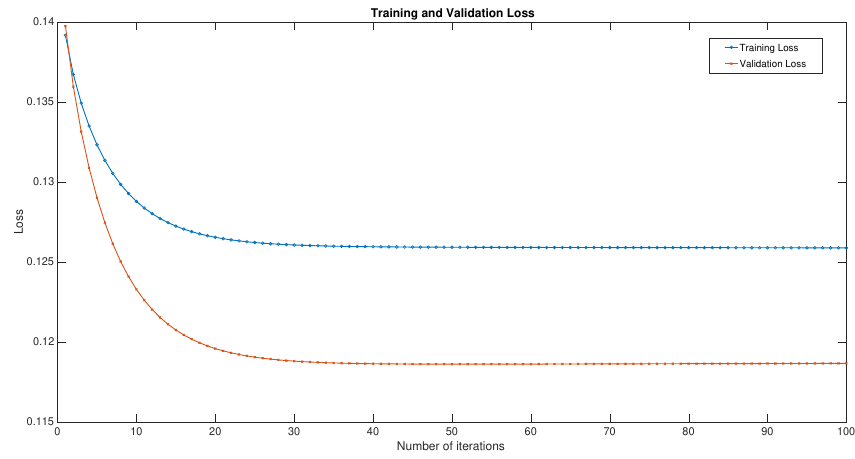
Figure 2. Loss plots of the iteration of Algorithm 3 from Table